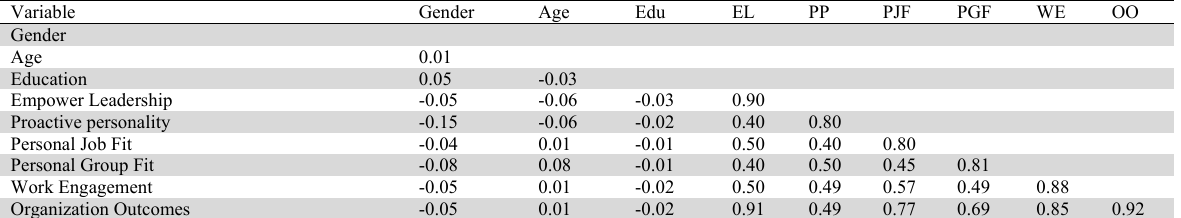
Correlations for all variables Variable